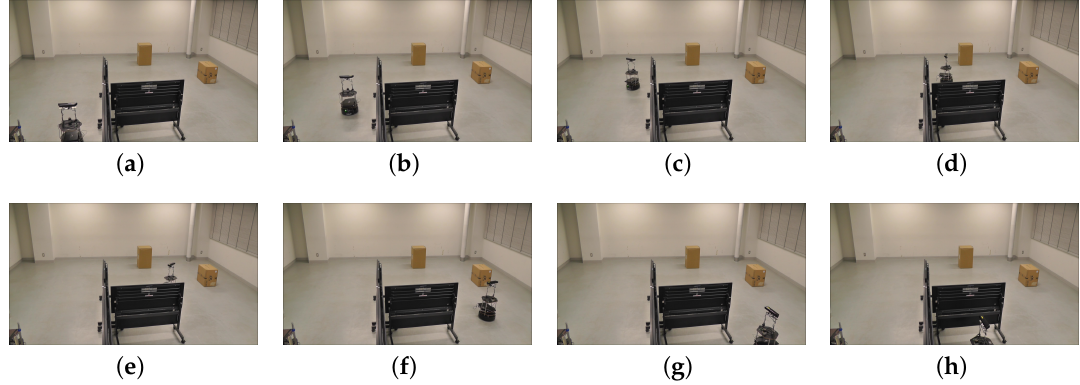
Figure 12. Timely snapshots of the experiment. ( a – h ) Turtlebot starts navigation with the